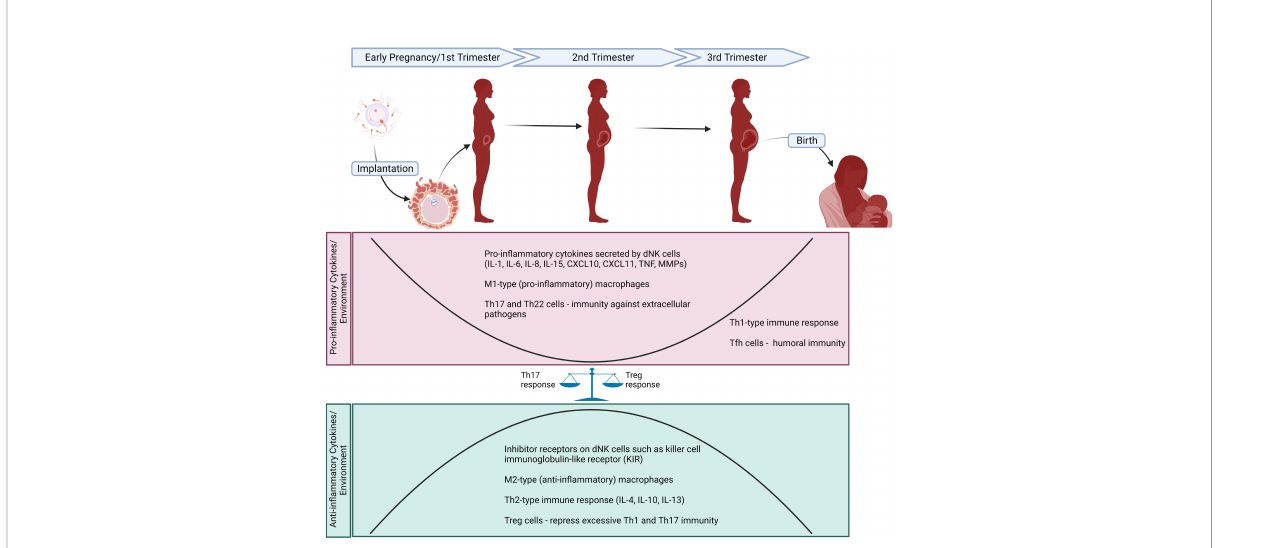
FIGURE 1 Schematic diagram of major changes in immune cells and in fl ammatory markers/cytokines during different stages of a normal pregnancy. First trimester is characterized by an initial pro-in fl ammatory stage necessary for implantation and placentation. dNK cells secrete high levels of pro- in fl ammatory factors including IL-1, IL-6, IL-8, IL-15, CXCL10, CXCL11, TNF, MMPs. Predominance of M1-type (pro-in fl ammatory) macrophages contribute to the in fl ammatory state observed in fi rst trimester. At second trimester, Th2-type immune response and immunomodulatory cytokines secreted by Th2 cells (e.g., IL-4, IL-10, IL-13) lead to an anti-in fl ammatory stage that is crucial for fetal growth. M2-type (anti- in fl ammatory) macrophages and increased expression of inhibitory receptors on dNK cells such as killer cell immunoglobulin-like receptor (KIR) play a signi fi cant role in maintaining immune tolerance in maternal-fetal interface. Finally, third trimester is de fi ned as a second pro- in fl ammatory stage and Th1-type immune state is thought to initiate labor and delivery. Other T helper cells including Th17, Th22, Treg and Tfh cells are also essential for healthy pregnancy. TH17 and Th22 cells offer immunity against extracellular pathogens at the maternal-fetal interface. Treg cells increase immune tolerance to fetus by repressing uncontrolled Th1 and Th17 immunity. Tfh cells provide humoral immunity by priming B cells to initiate extrafollicular and germinal center antibody responses in third trimester. Created with